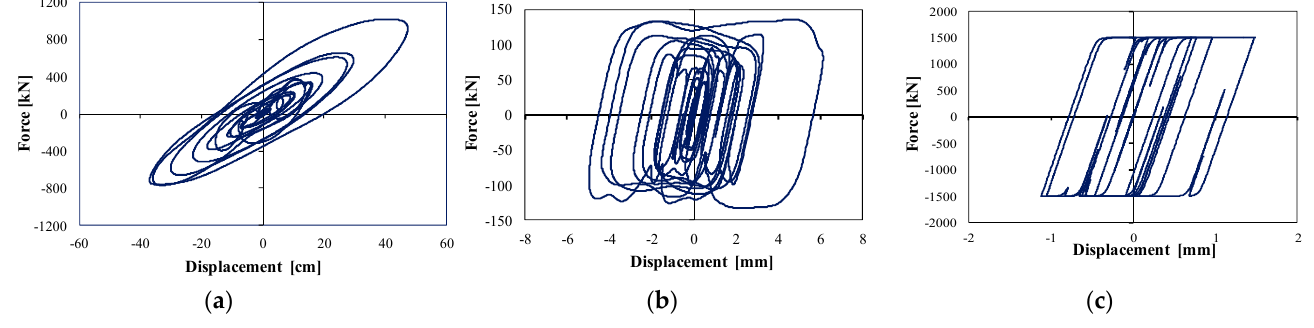
Figure 16. Hysteretic loops for ( a ) PTMD, ( b ) VD, ( c ) FD.